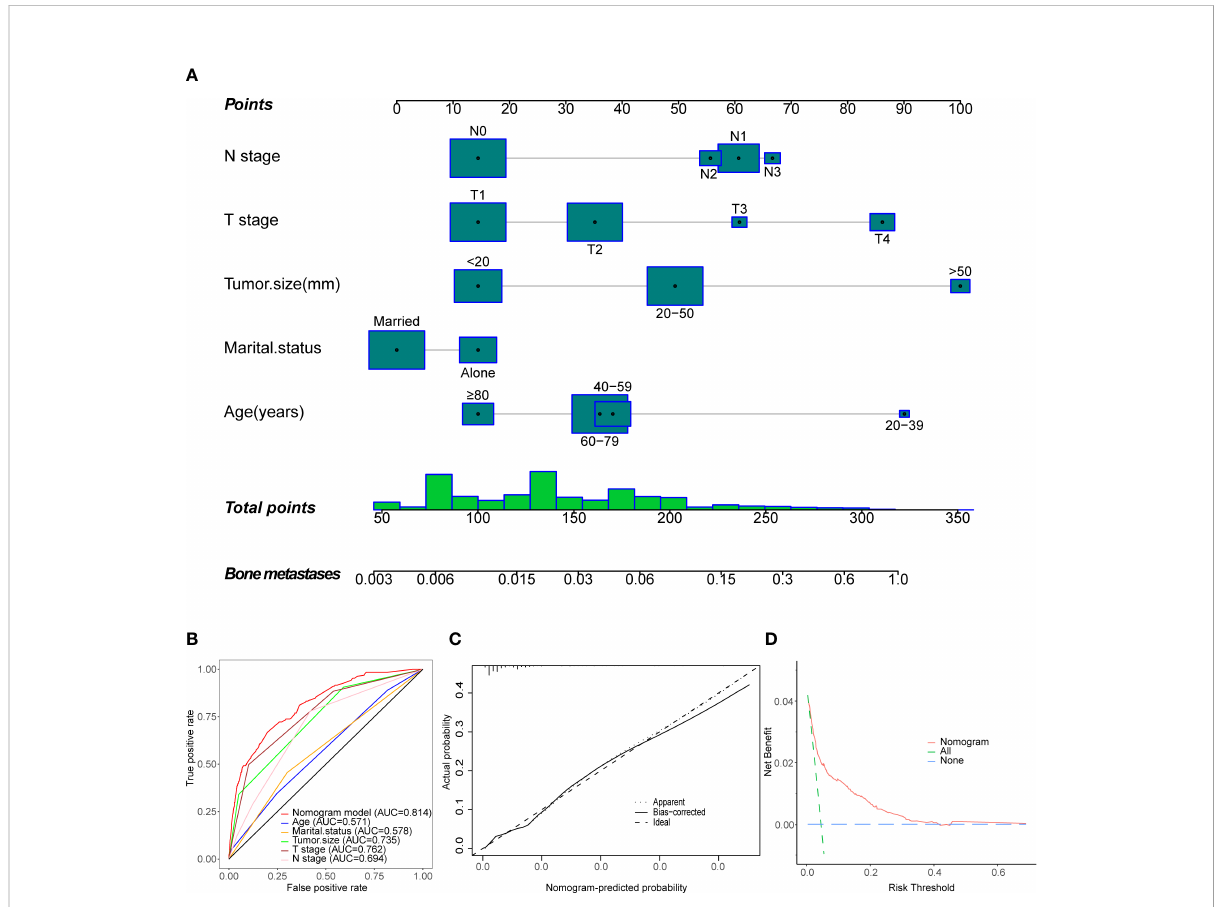
FIGURE 2 Establishment and validation of a diagnostic nomogram to estimate the risk of BM in MBC patients. (A) The diagnostic nomogram. (B) The receiver operating characteristic curve (ROC). (C) The Calibration curve. (D) The decision curve analysis